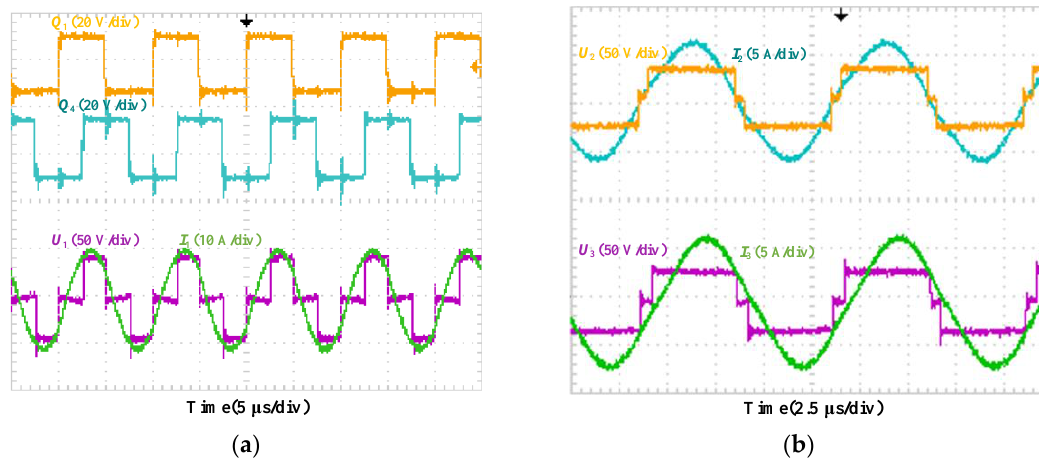
Figure 8. Experimental waveform: ( a ) transmitter coil; ( b ) receiver coils.